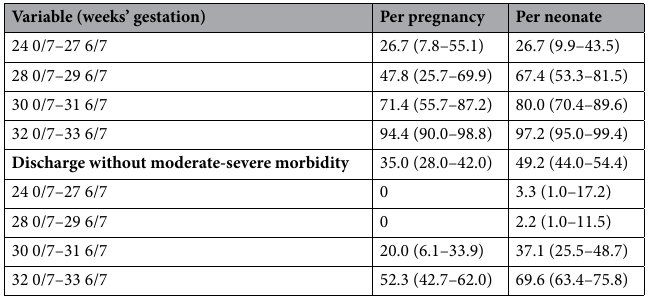
Table 3. Neonatal morbidity and mortality associated with PPROM in twin pregnancies by GA at membrane rupture. Data are % (95% CI).